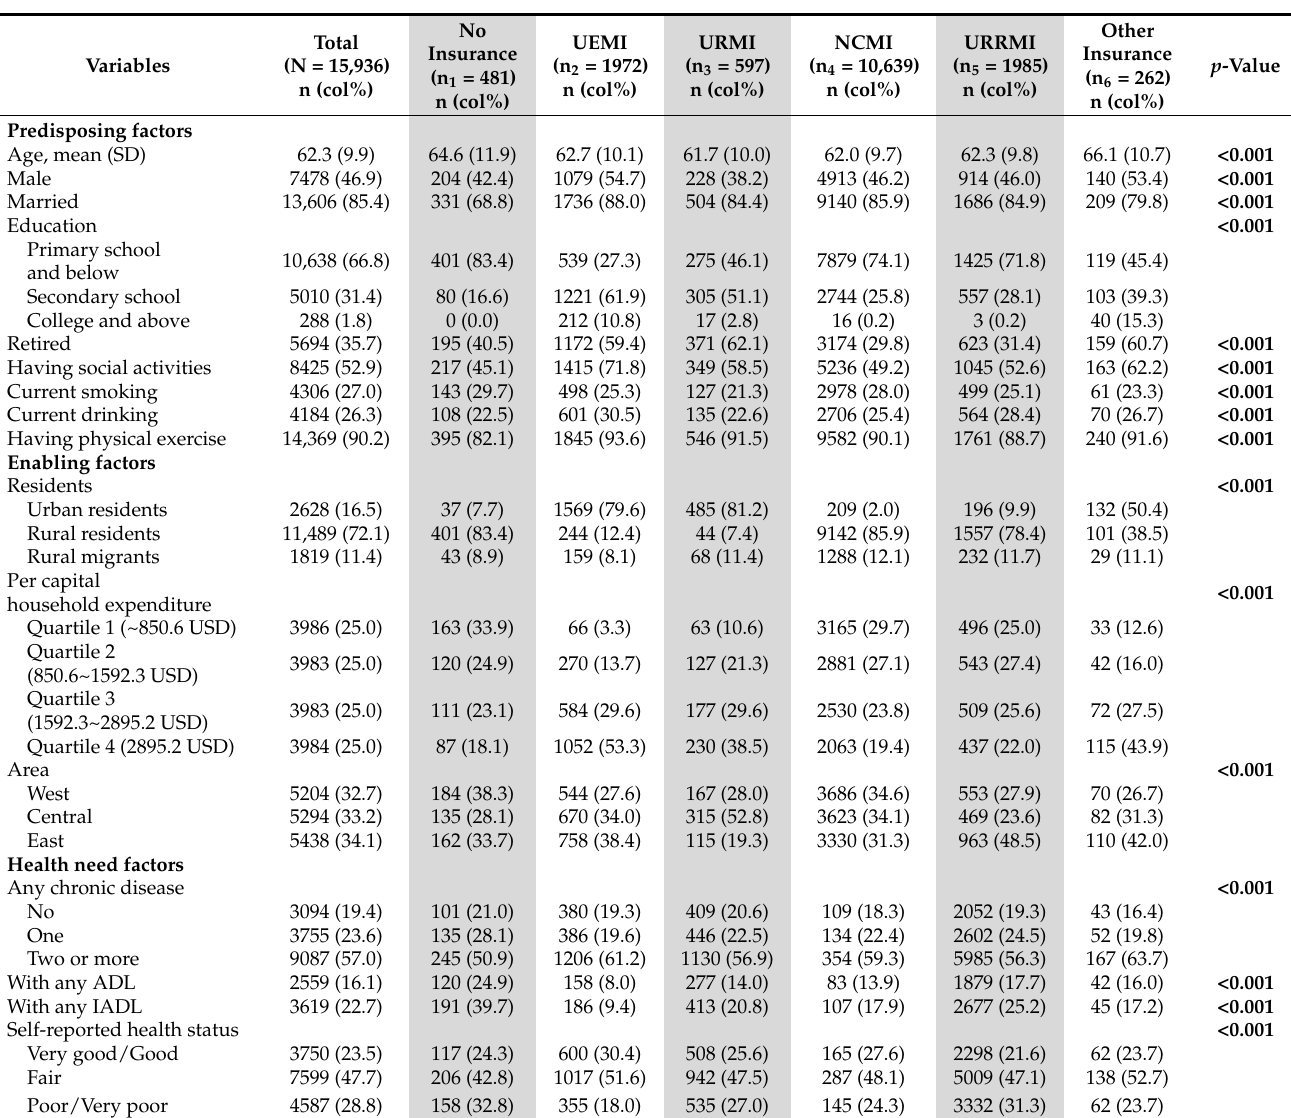
Table 2. Background characteristics by predisposing, enabling and health need factors among older Chinese,